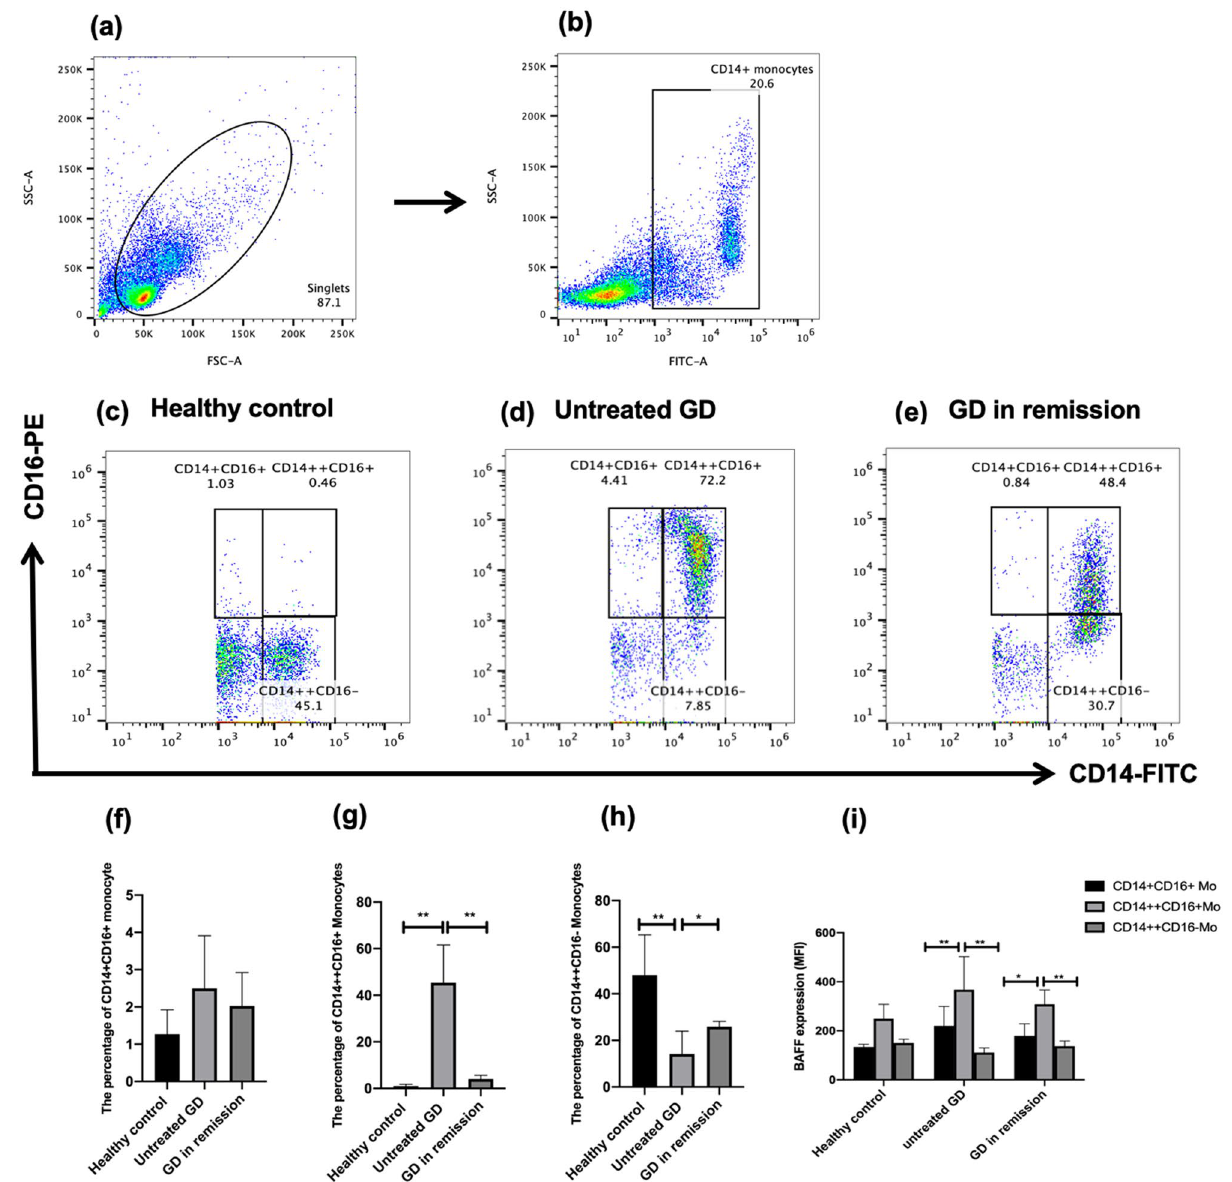
Figure 2. Characterization of the monocyte subsets in healthy controls and patients with Graves’ disease. (a,b) showed the gating strategy for monocytes, (c–e) representative dot plots of CD14 and CD16 expression on monocytes from healthy controls, untreated GD patients and GD patients in remission; (f) showed the percentages of CD14+ CD16+ monocytes (non-classical monocytes), (g) showed the percentages of CD14++ CD16+ monocytes (intermediate monocytes) and (h) showed the percentages of CD14++ CD16- monocytes (classical monocytes) from healthy control subjects (n = 10), untreated GD (n = 24) and negative TRAb GD in remission (n = 6), (i) showed the mean fluorescence intensity (MFI) of BAFF on different monocytes subsets; * P < 0.05, ** P <